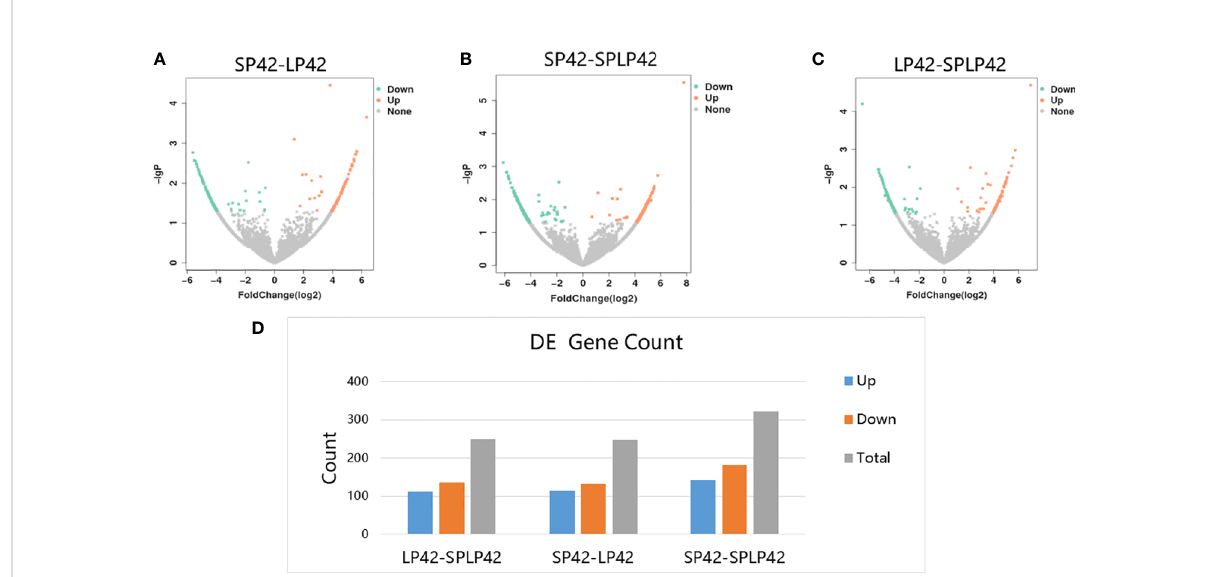
FIGURE 3 Analysis of circRNAs differentially expressed in the different photoperiods of ovine thyroid gland. (A) Volcano map of differentially expressed circRNA in SP42-LP42. (B) Volcano map of differentially expressed circRNA in SP42 and SPLP42. (C) Volcano map of differentially expressed circRNA in LP42-SPLP42. (D) Analysis of circRNAs differentially expressed in LP42-SPLP42, SP42-LP42 and